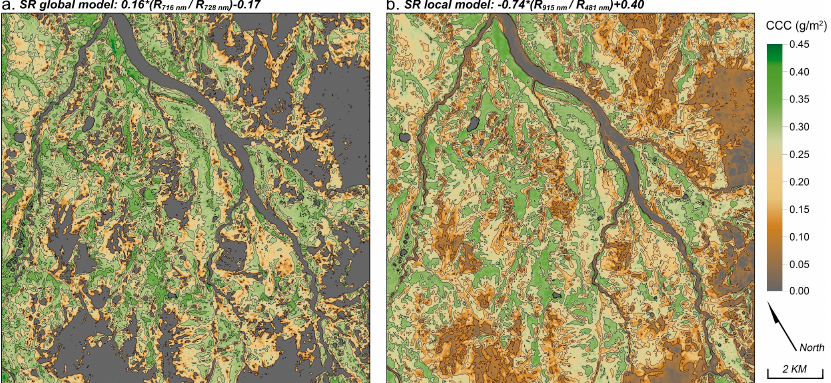
Figure 5. Simple ratio (SR) -based global model ( a ) and local model ( b ) predictions for canopy chlorophyll content (CCC) for Banks Island, 2012. Both CCC models were developed and applied to the 0° view zenith angle (VZA). Wavelengths (optimal bands) used for each retrieval are shown above the maps. Predictive maps are shown raster up for visualization purposes (see Figure 1 for geographic orientation of the image).